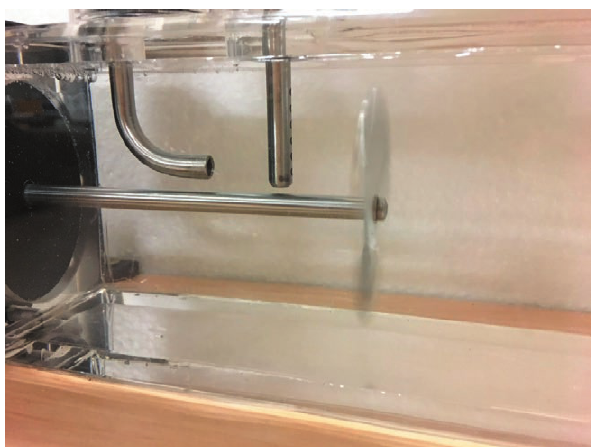
Figure 10. Cavitation completely prevented in gassed tap water after flowing 80% de-gassed water directly onto the rotating propel- ler blades (at 2300 rpm).